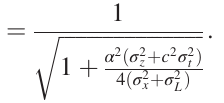
( μ rad), for Δ E L =E L ¼ 0 and max θ ( μ max